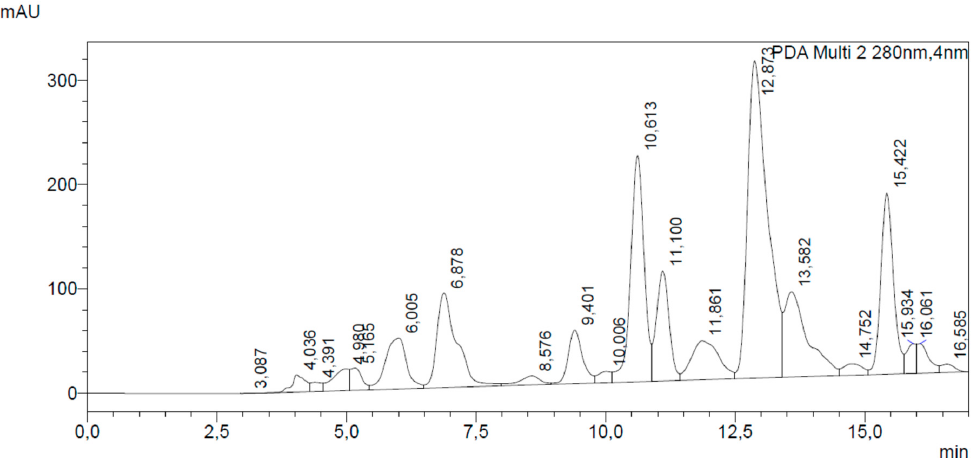
Figure 1. DAD chromatogram recorded at 280 nm of tested propolis sample. Galangin (RT = 12.87 min) and pinocembrin (RT = 10.61) were the main flavonoids in the extract. Table 1. Content of the main chemical markers of the studied poplar-type propolis (PP). Constituent Content [mg / g Dry